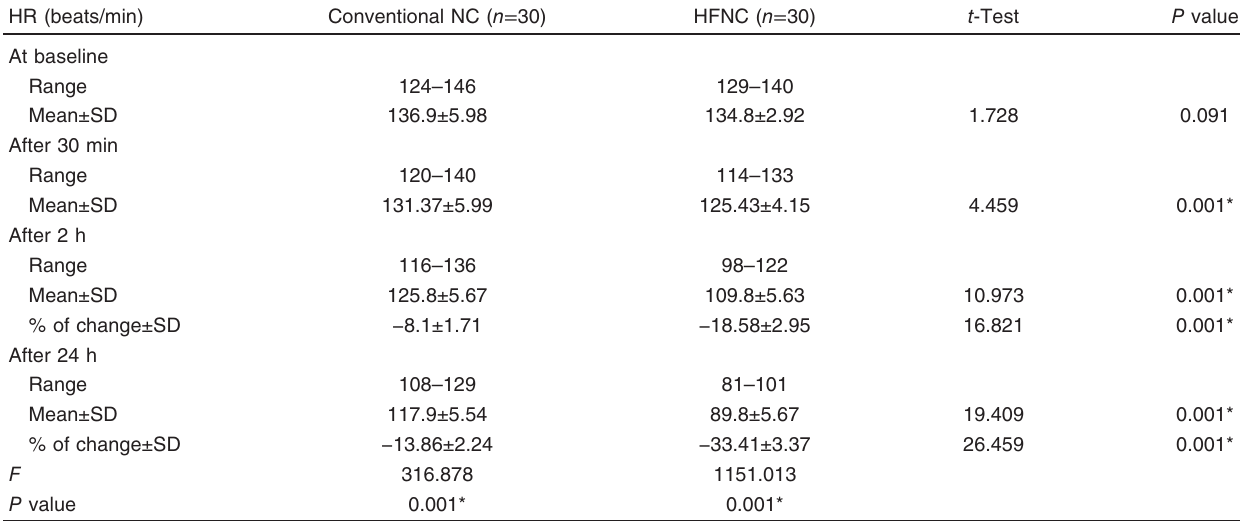
Table 5 Comparison of heart rate between the two studied groups